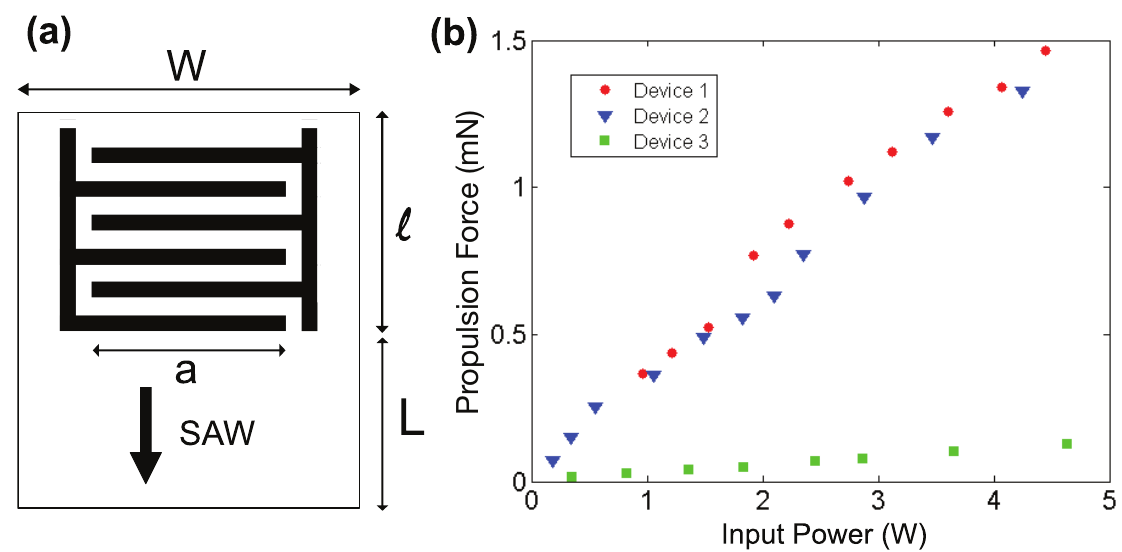
Figure 4. ( a ) The layout of the basic SAW device design in our trials using the pendulum force balance method. We denote the chip width, the IDT aperture, the IDT length, and the chip length for SAW propagation and attenuation in fluid as W , a , l , and L , respectively. We only consider SAW propagated towards the bottom of the chip, as the SAW propagating upward from the IDT is absorbed by an absorber mounted at the top edge of the chip. Three versions of this design produce ( b ) substantially different propulsion forces for an input power from 0 to 5